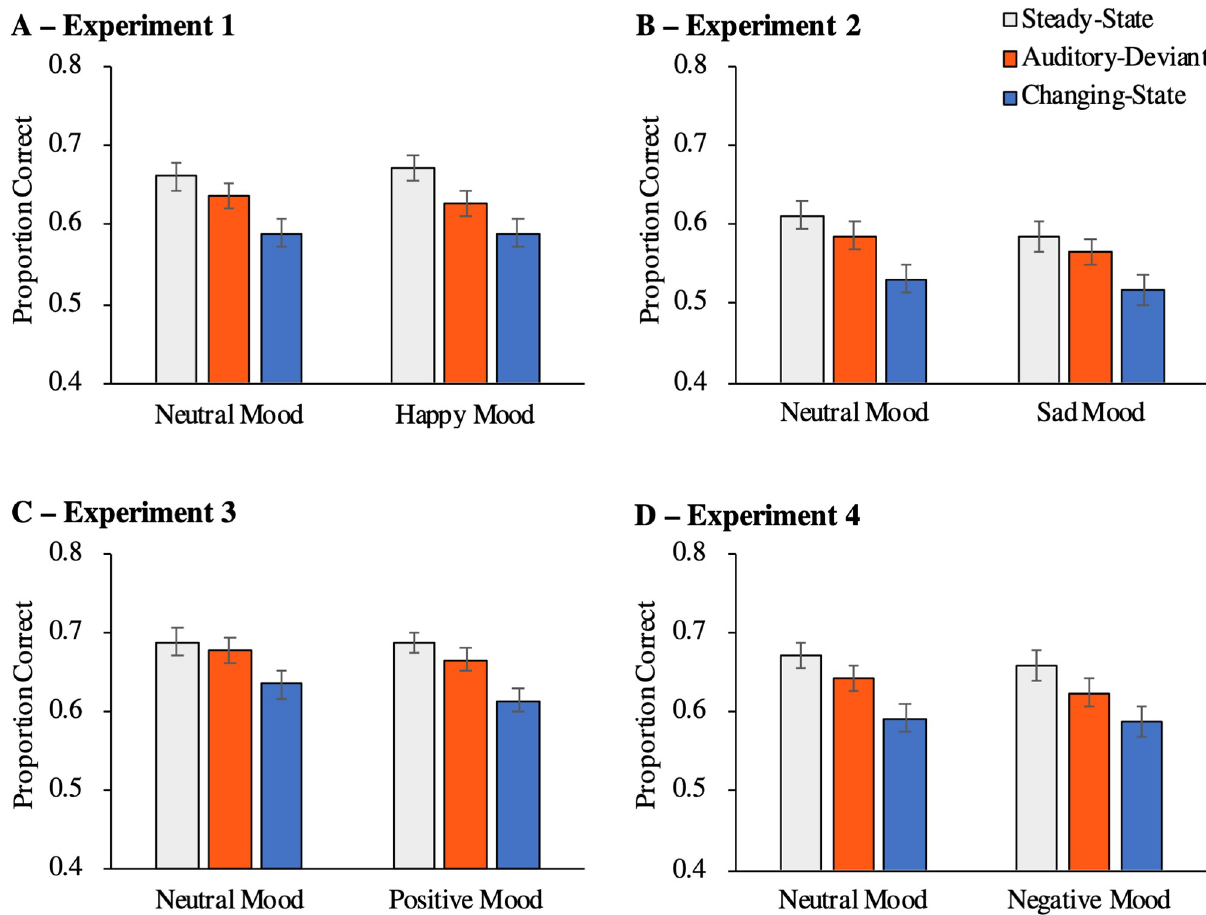
Fig 3. Proportion of correct responses in serial recall as a function of distractor condition and mood. The error bars represent the standard errors of the means. (A) Results of Experiment 1. (B) Results of Experiment 2. (C) Results of Experiment 3. (D) Results of Experiment 4.